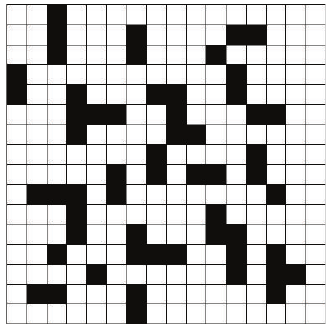
Figure 8: More expressive representation level